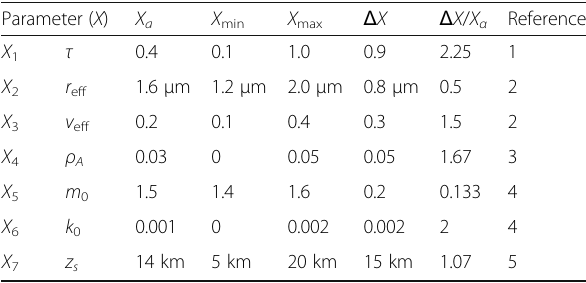
Table 1 Dust model parameters ( X 1 – X 7 )